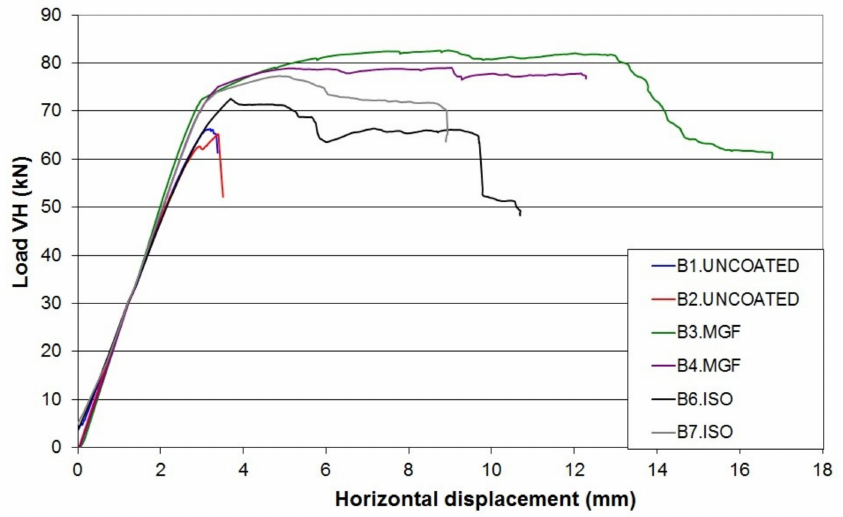
Figure 3. Force–displacement relationship of the tested specimens.